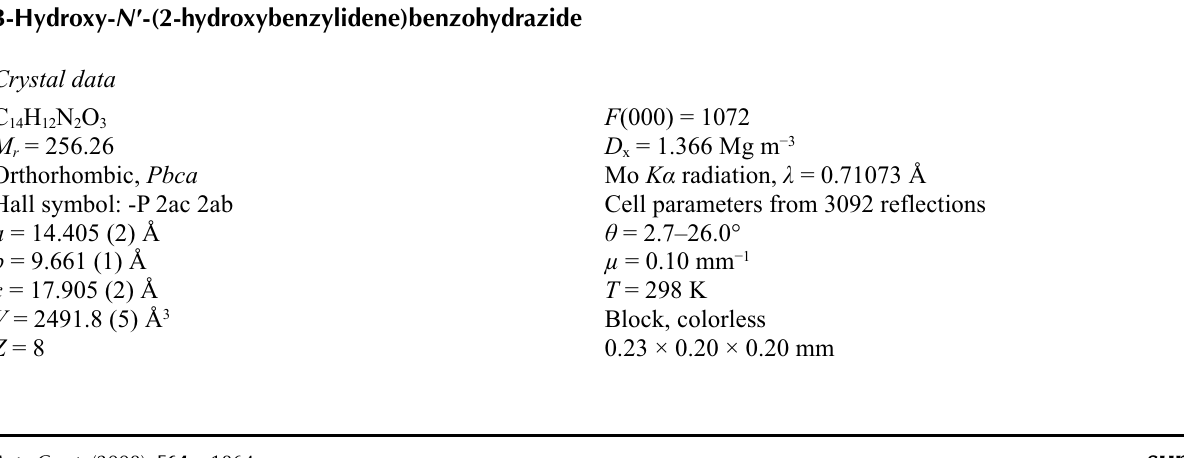
Packing diagram, viewed along the a axis. Hydrogen bonds are shown as dashed lines. 3-Hydroxy- N ′